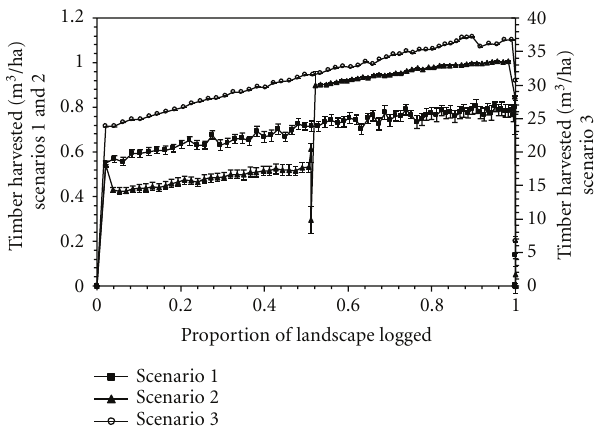
Figure 2: Timber harvested rates over 80 years of selective logging simulations.